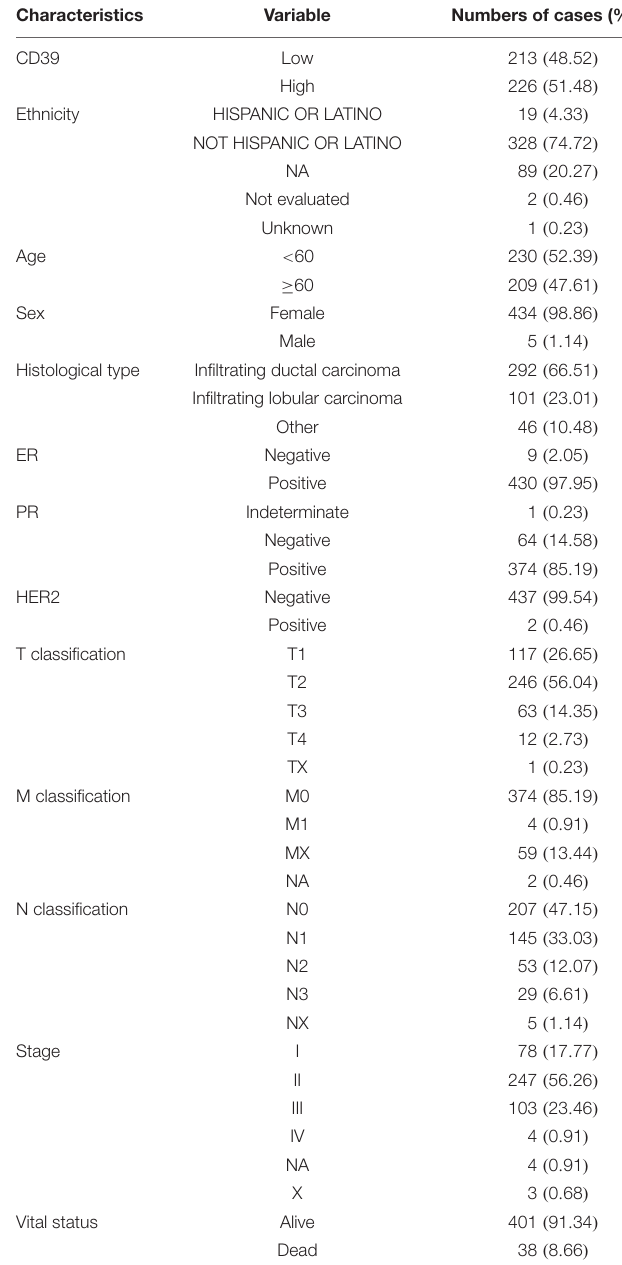
TABLE 1 | Clinical characteristics of TCGA-BRCA level 3